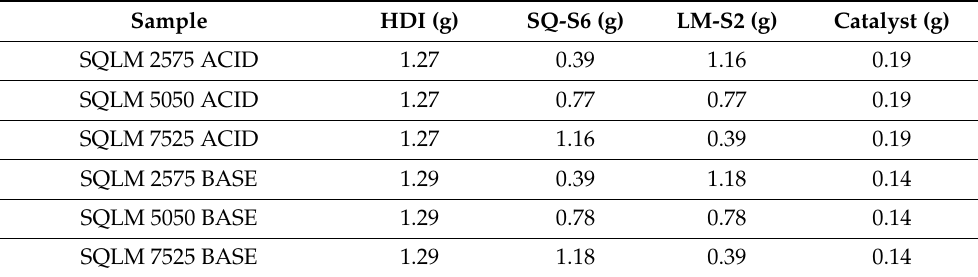
Table 1. Composition and nomenclature of the samples of renewable thiols